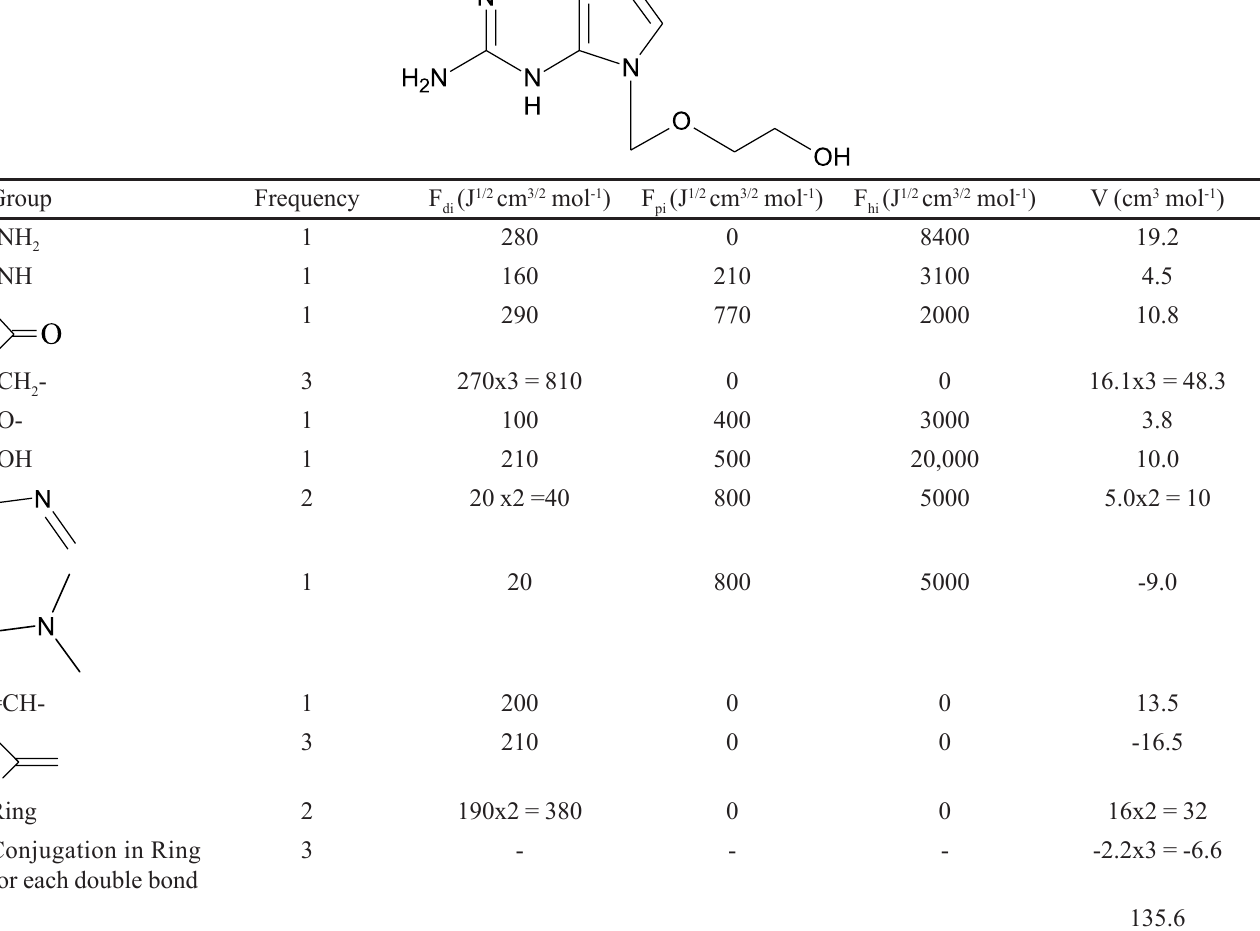
TABLE I - HSPs and molar volume calculations for acyclovir according to the Hoftyer-Van Krevelen method